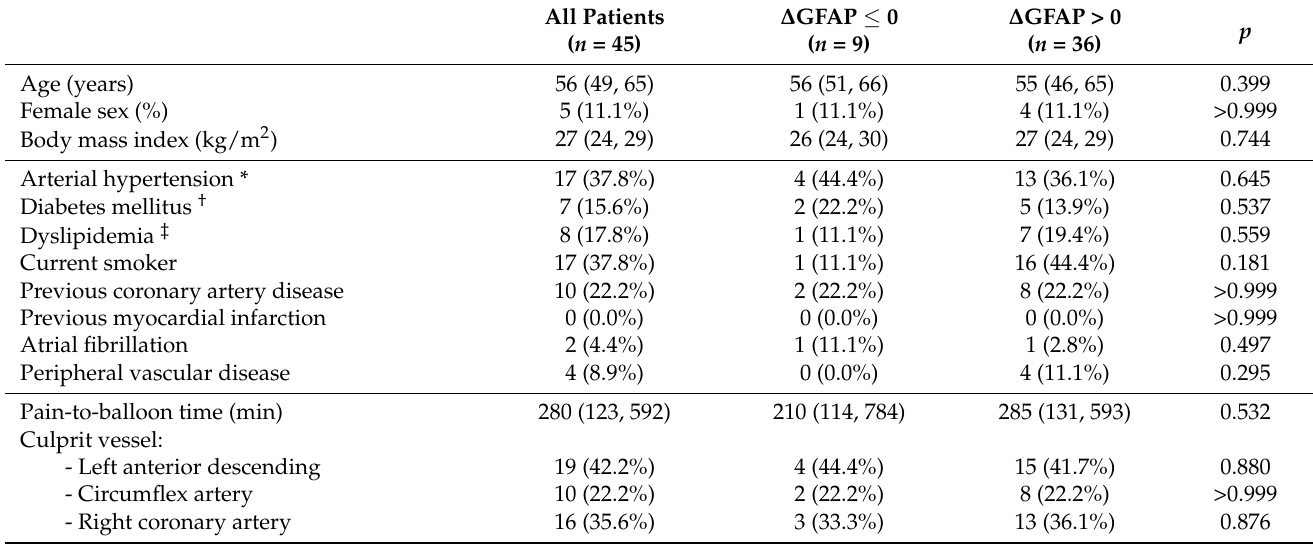
Table 1. Patient characteristics according to GFAP increase or decrease 12 months after